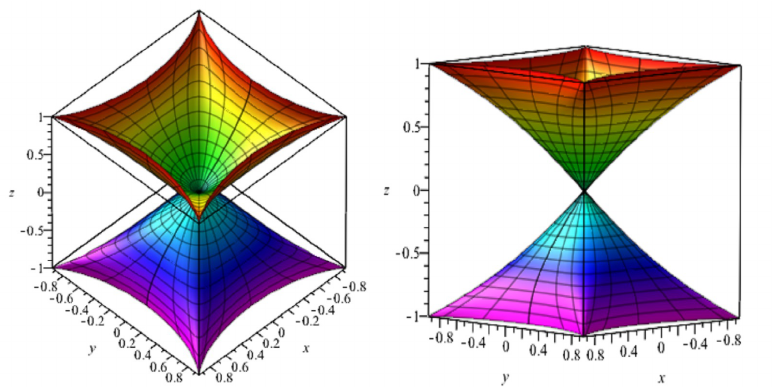
Figure 2. Two views of the rotational surface of value ( 0,1 ) , ϕ ( r ) = r .